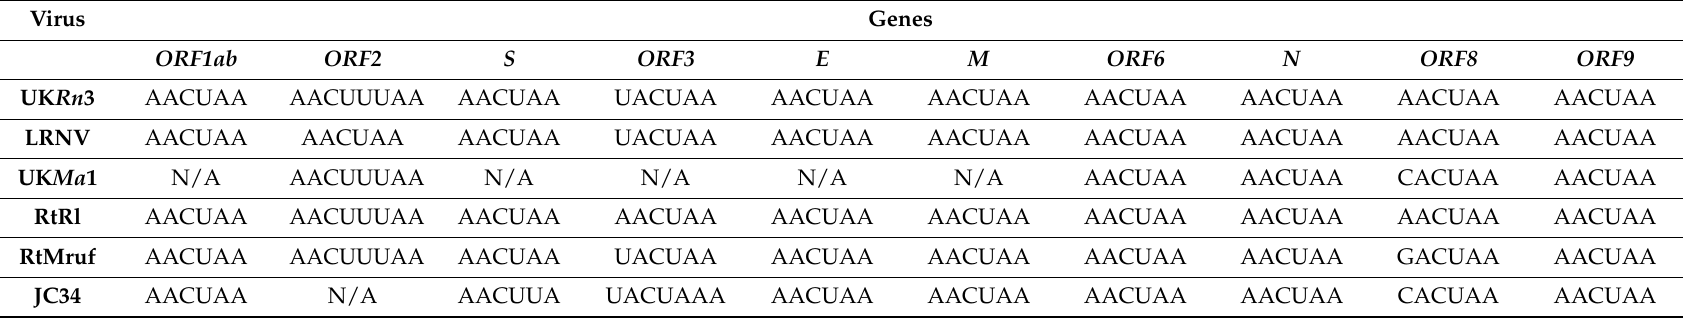
Table 3. List of all the predicted core transcription regulatory sequences (TRS) for all the genes of the rodent alpha-CoVs. Core TRS could not be predicted for ORF1ab, S, ORF3, E, and M for UKMa1 as there was no available sequence for those genes. AcCoV-JC34 did not possess an ORF2 such that there was no core TRS for that